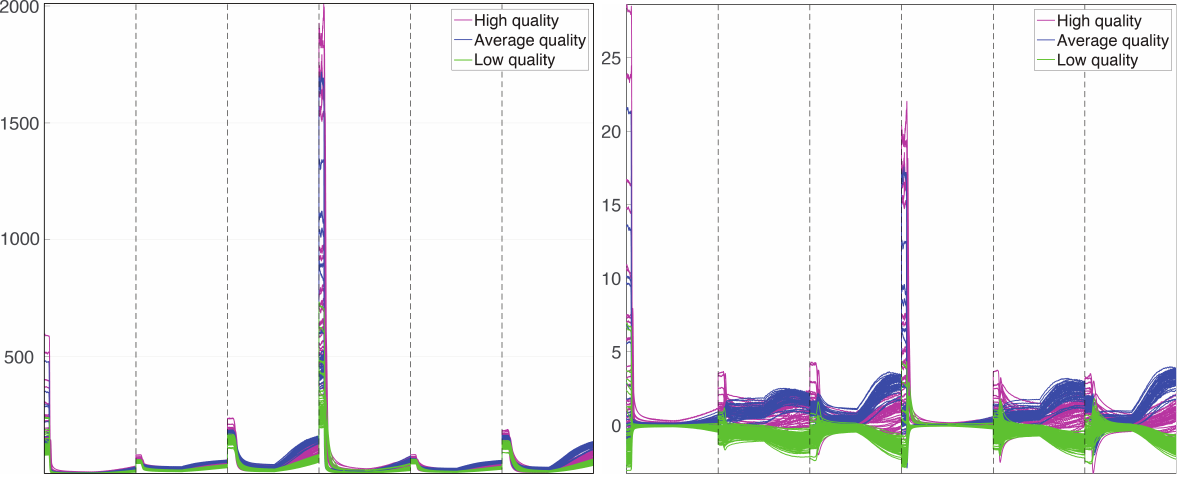
Figure 7. Unfolded data in dataset #2. Initial values ( left ) and MCUGS signal ( right ). All experiments shown are superposed (3330 values per 6 sensor signals for 235